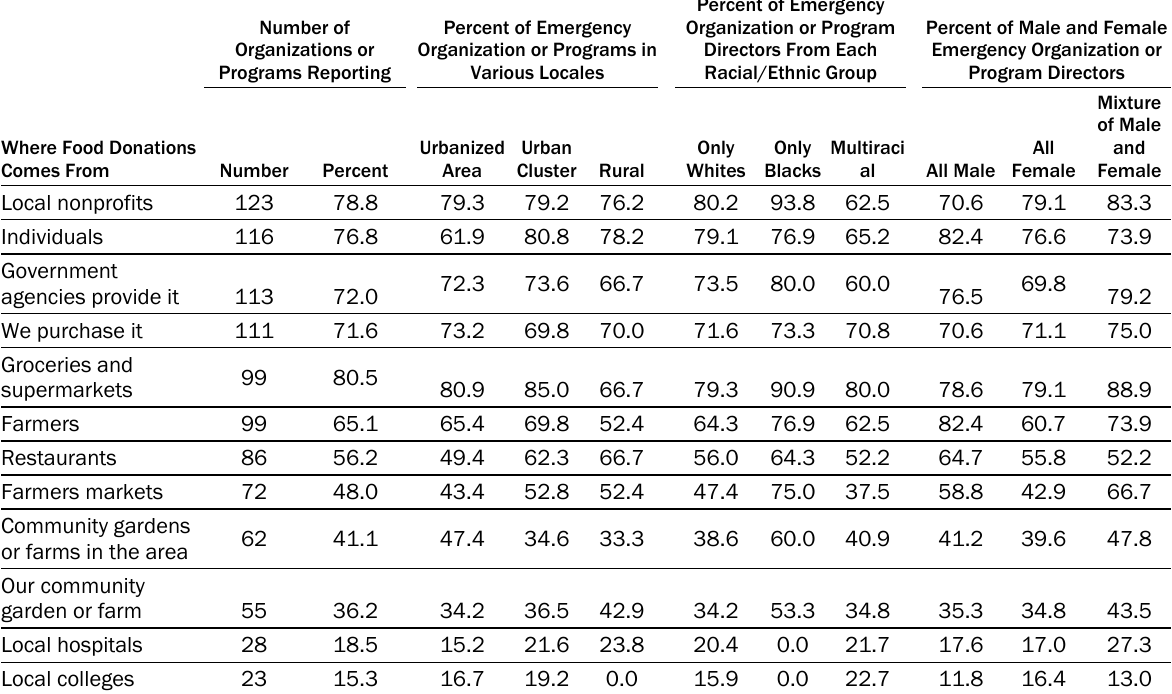
Table 6. Where the Food that is Served or Distributed by Emergency Food Assistance Organizations and Programs Comes